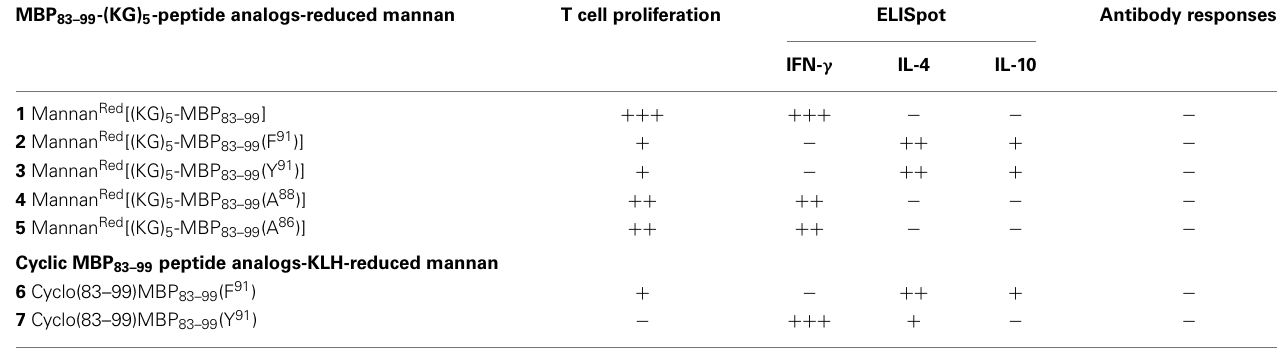
Table 1 | Summary of T cell proliferative, cytokine, and antibody responses .